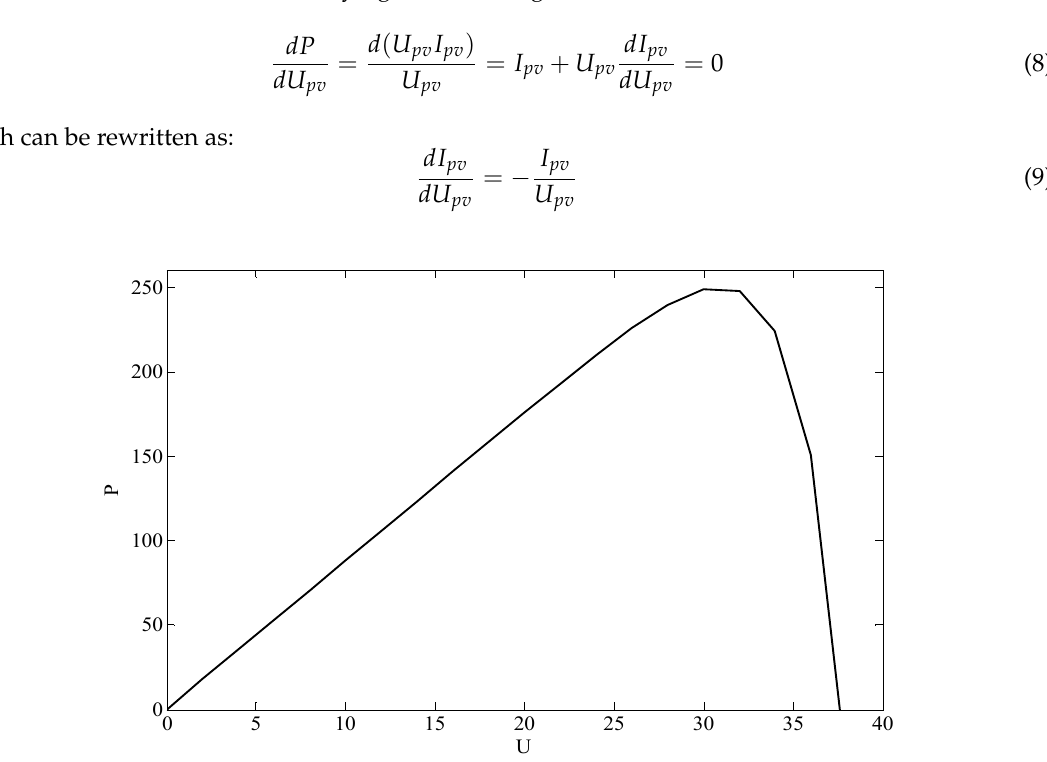
Figure 4. P–U characteristic of PV cells.